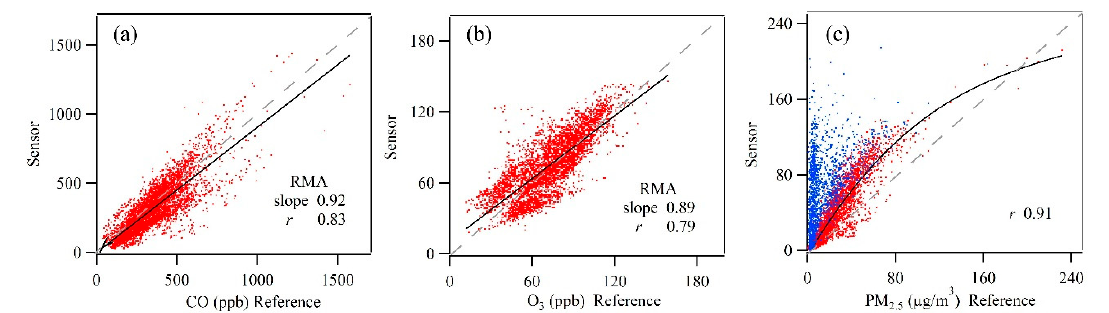
Figure 5. Scatter plots of ( a ) CO, ( b ) O 3 , and ( c ) PM 2.5 between low-cost air quality sensor and the benchmark instruments (blue dots were at RH >95%). RMA: reduced major axis.